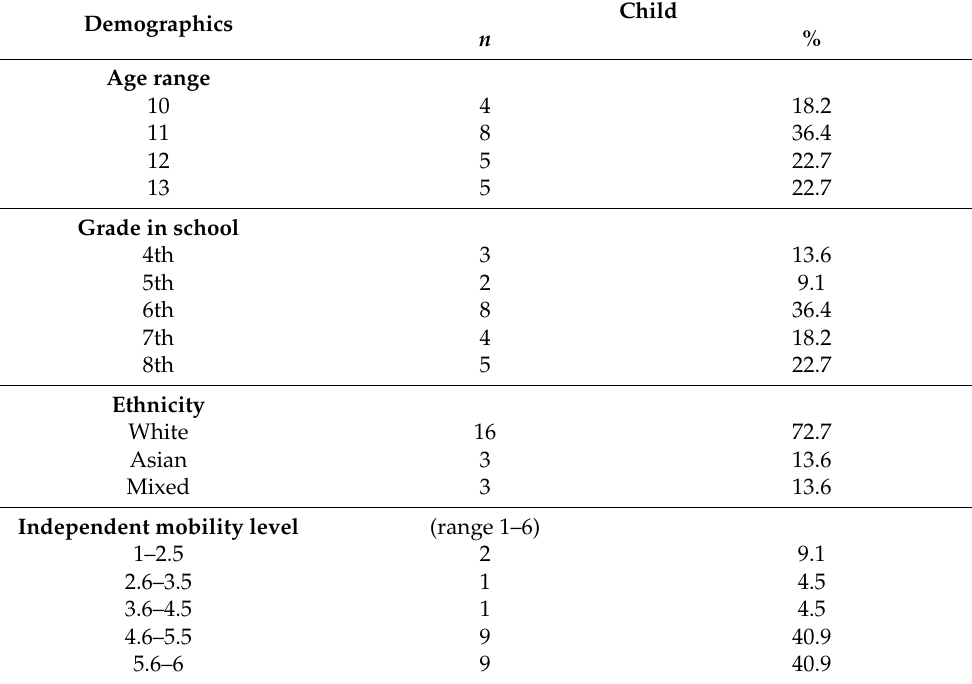
Table 2. Child demographic